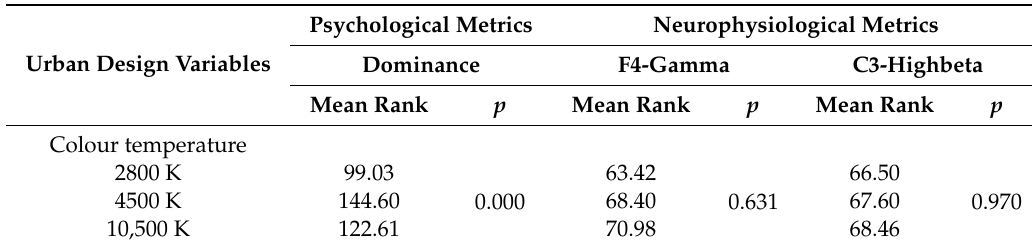
Kruskal-Wallis test for the di ff erences in the mean ranks of the psychological and neurophysiological metrics colour temperature and lighting (significance level p <